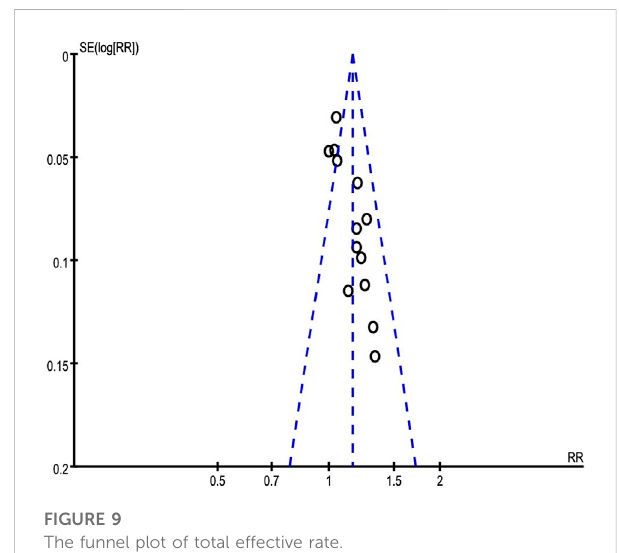
FIGURE 9 The funnel plot of total effective